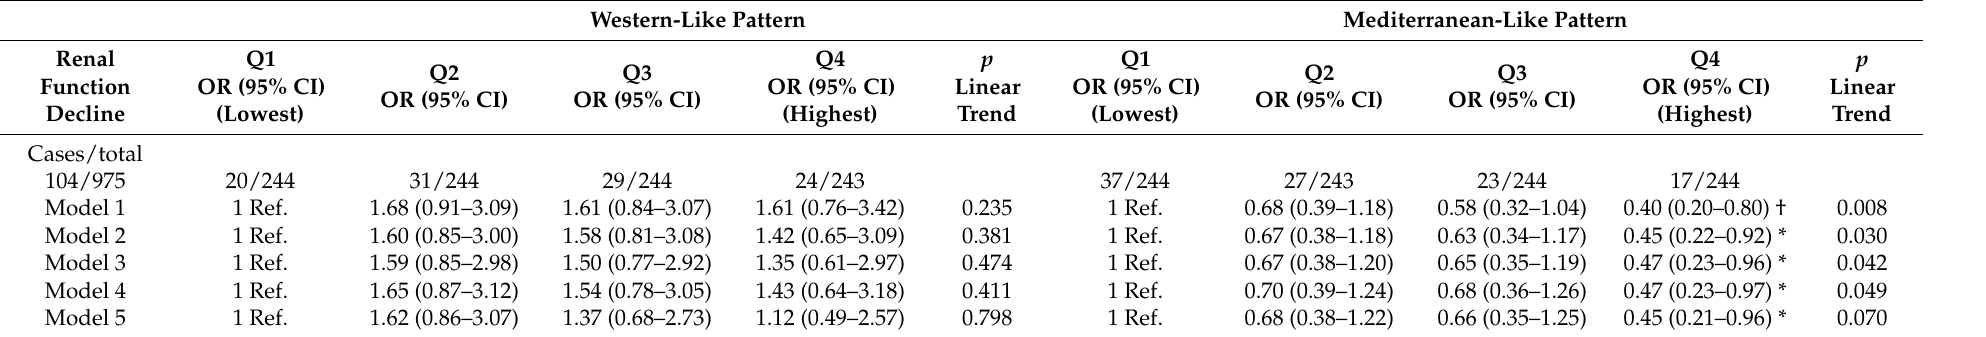
Table 3. Association between the adherence to a posteriori dietary patterns and the risk of renal function decline after 6.5-years of follow-up in the Seniors-ENRICA study (2008/2010–2015) N =